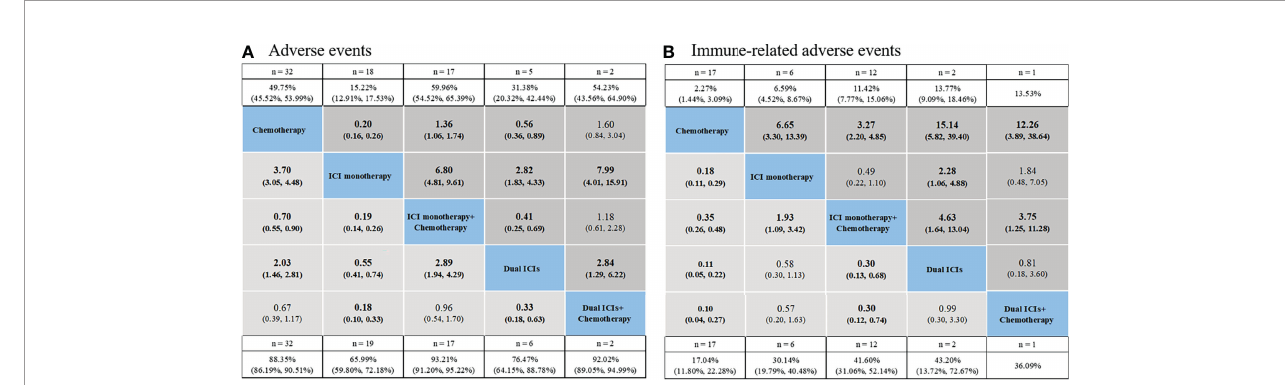
FIGURE 3 | Safety pro fi les based on adverse events (A) and immune-related adverse events (B) . Pooled incidences and 95% con fi dence intervals of grade 1 – 5 events for each treatment are at bottom and that of grade 3 – 5 events are at top of the fi gure. Each cell of the safety pro fi les contains the pooled relative risks and 95% con fi dence intervals for grade 1 – 5 (light gray cell) and grade 3 – 5 (dark gray cell) events; signi fi cant results are in bold. The pooled relative risks and 95% con fi dence intervals indicate the results of the top treatment compared with the bottom treatment. ICI, immune checkpoint inhibitor; n,